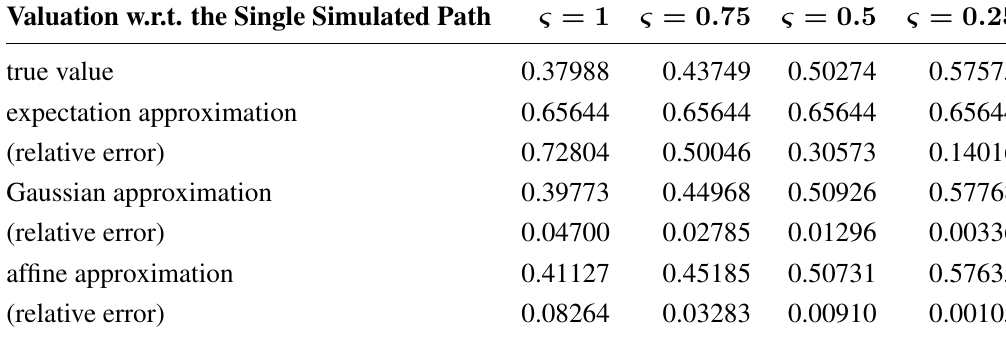
Table 1. One-path simulation for (40) and its corresponding expectation approximation, Gaussian approximation and affine approximation.